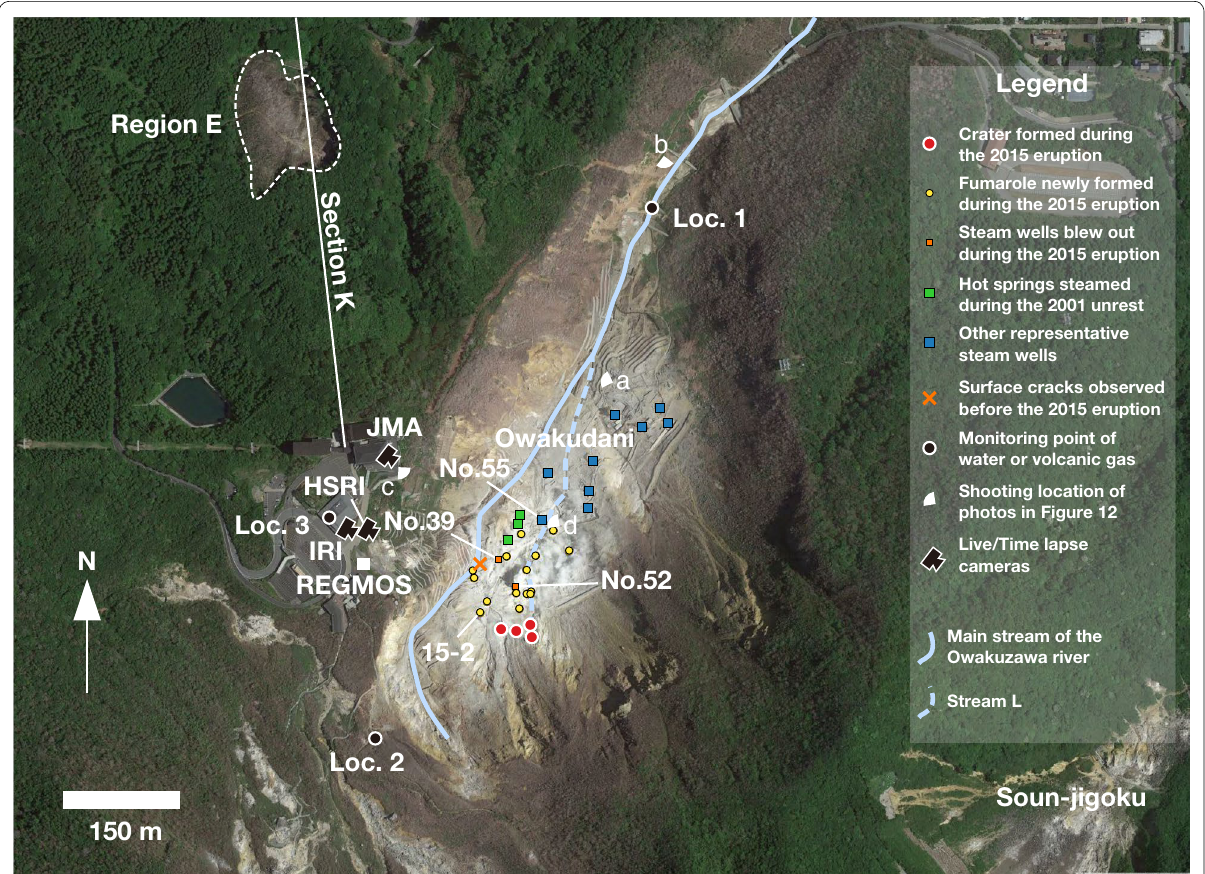
Fig. 2 Aerial photograph of Owakudani and surrounding area (photograph source: Google Earth). Region E indicates a steaming area newly formed in 2011 (see text). Section K indicates a line along which cross-sectional structure of resistivity is shown (Fig.